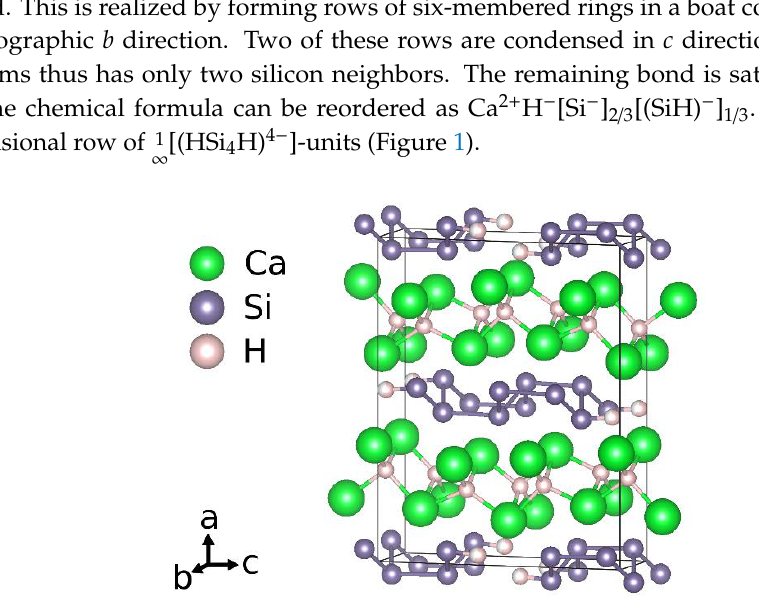
Figure 1. Crystal structure according to an idealized chemical formula CaSiH 4/3 .